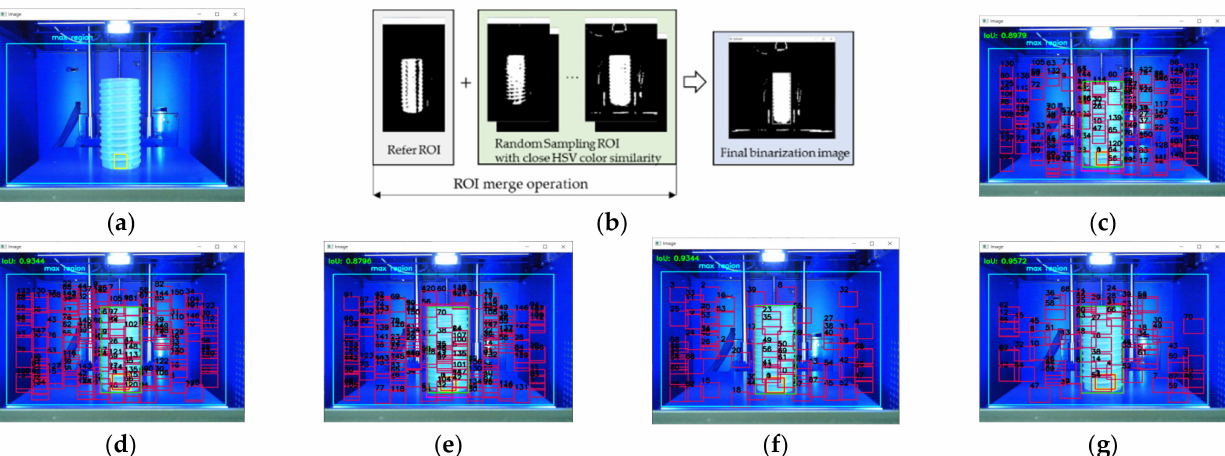
Figure 11. Test 1 product result of the proposed algorithm: ( a ) reference ROI for auto HSV color picking; ( b ) merge operation through random sample ROIs with close HSV Color similarity; ( c ) Test 1 product result (random sampling ROI: 150); ( d ) another Test 1 product result (random sampling ROI: 150); ( e ) another Test 1 product result (random sampling